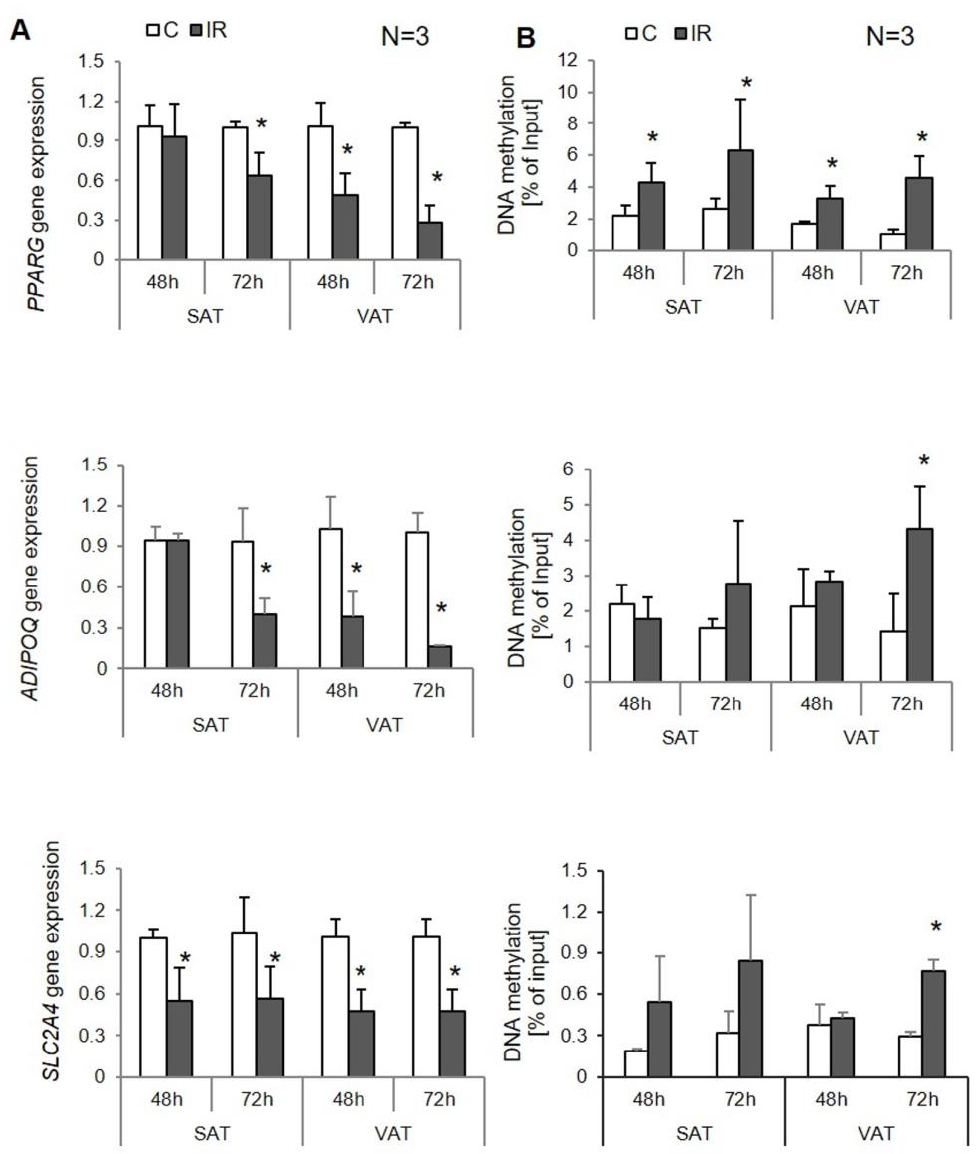
Figure 4. The insulin-sensitizing genes expression and their site-specific DNA methylation in human adipocytes (SAT and VAT). Controls (C) and induced insulin resistance (IR): ( A ) gene expression (normalized to β -actin gene), ( B ) site-specific DNA methylation (% of input), * p < 0.05. Contrary to SAT-derived adipocytes, in VAT-derived adipocytes, changes in expression In insulin-resistant SAT-derived adipocytes, the methylation of the SLC2A4 and AD- of analyzed genes were detected at both time points: after 48 h and 72 h. The expression of IPOQ promoters were increased at both time points without being statistically significant. the SLC2A4 gene was decreased by about 50% in insulin-resistant adipocytes compared to controls (48 h: p = 0.015, 72 h: p = 0.001). The expression of the ADIPOQ gene decreased about 50% in IR cell after 48 h ( p = 0.013) and about 80% after 72 h ( p = 0.012). The PPARG gene was downregulated by about 50% after 48 h ( p = 0.002) and 70% after 72